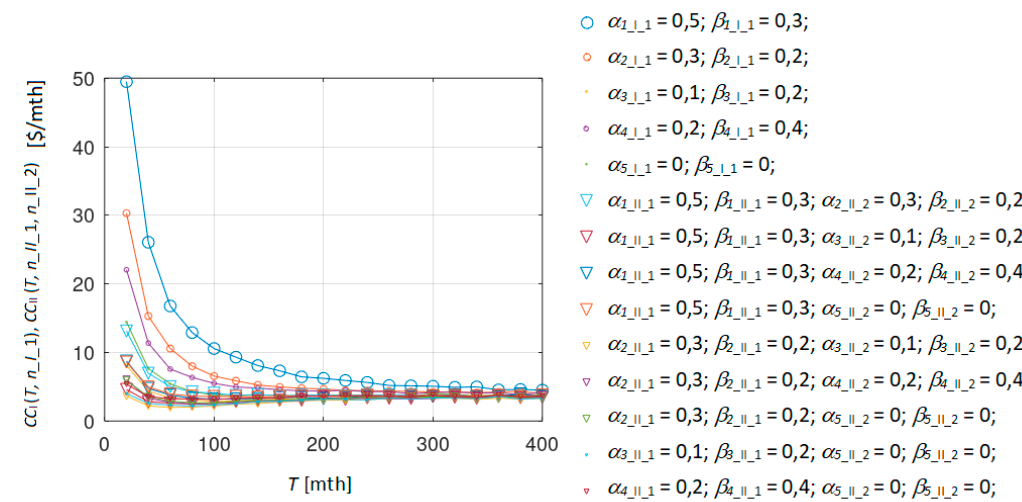
Figure 3. The expected cost per unit time for the inspection interval T if the one-stage and various combinations of the two-stage policy are applied.